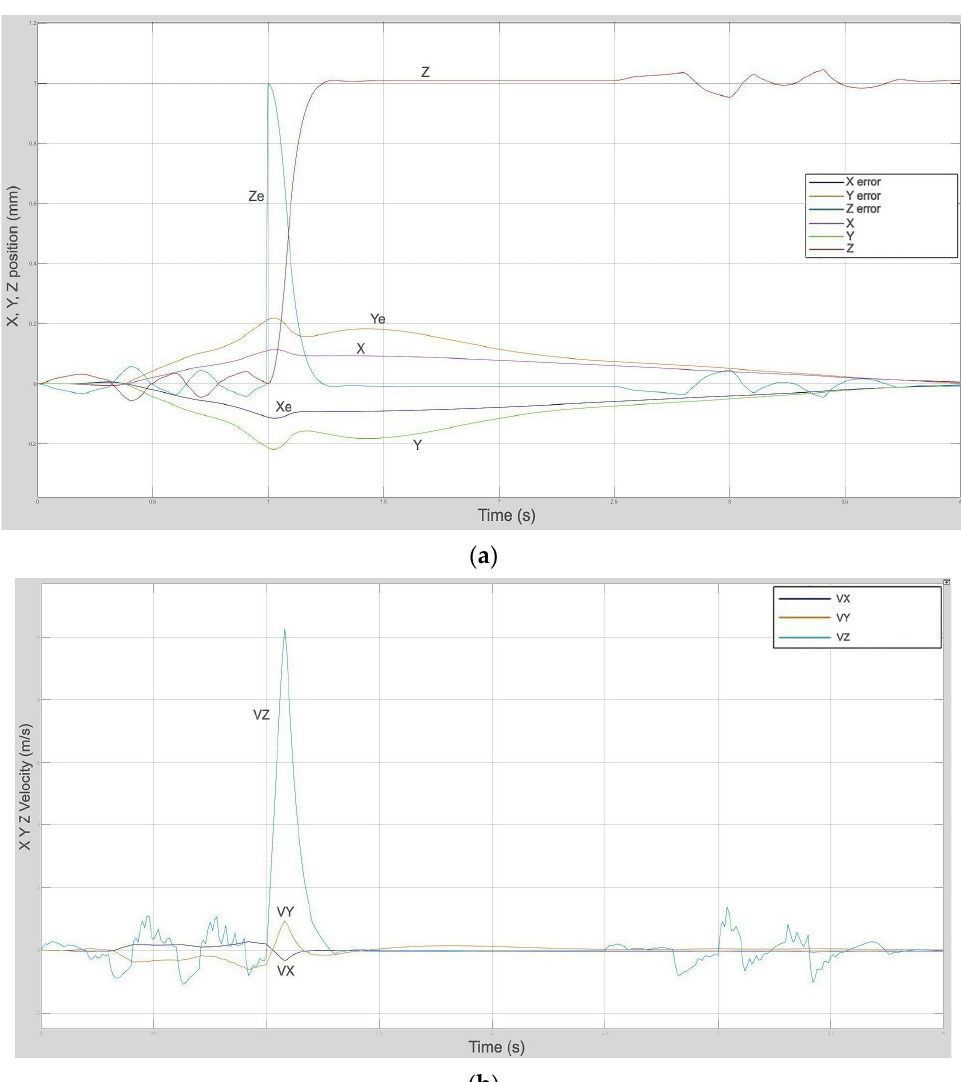
Figure 17. Position tracking error. ( a ) Position tracking error. ( b ) Drone velocity along coordinate axes.